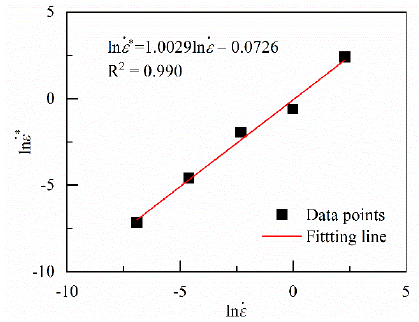
Figure 12. Flow chart of establishing the modified Hensel–Spittel (mHS) equation.